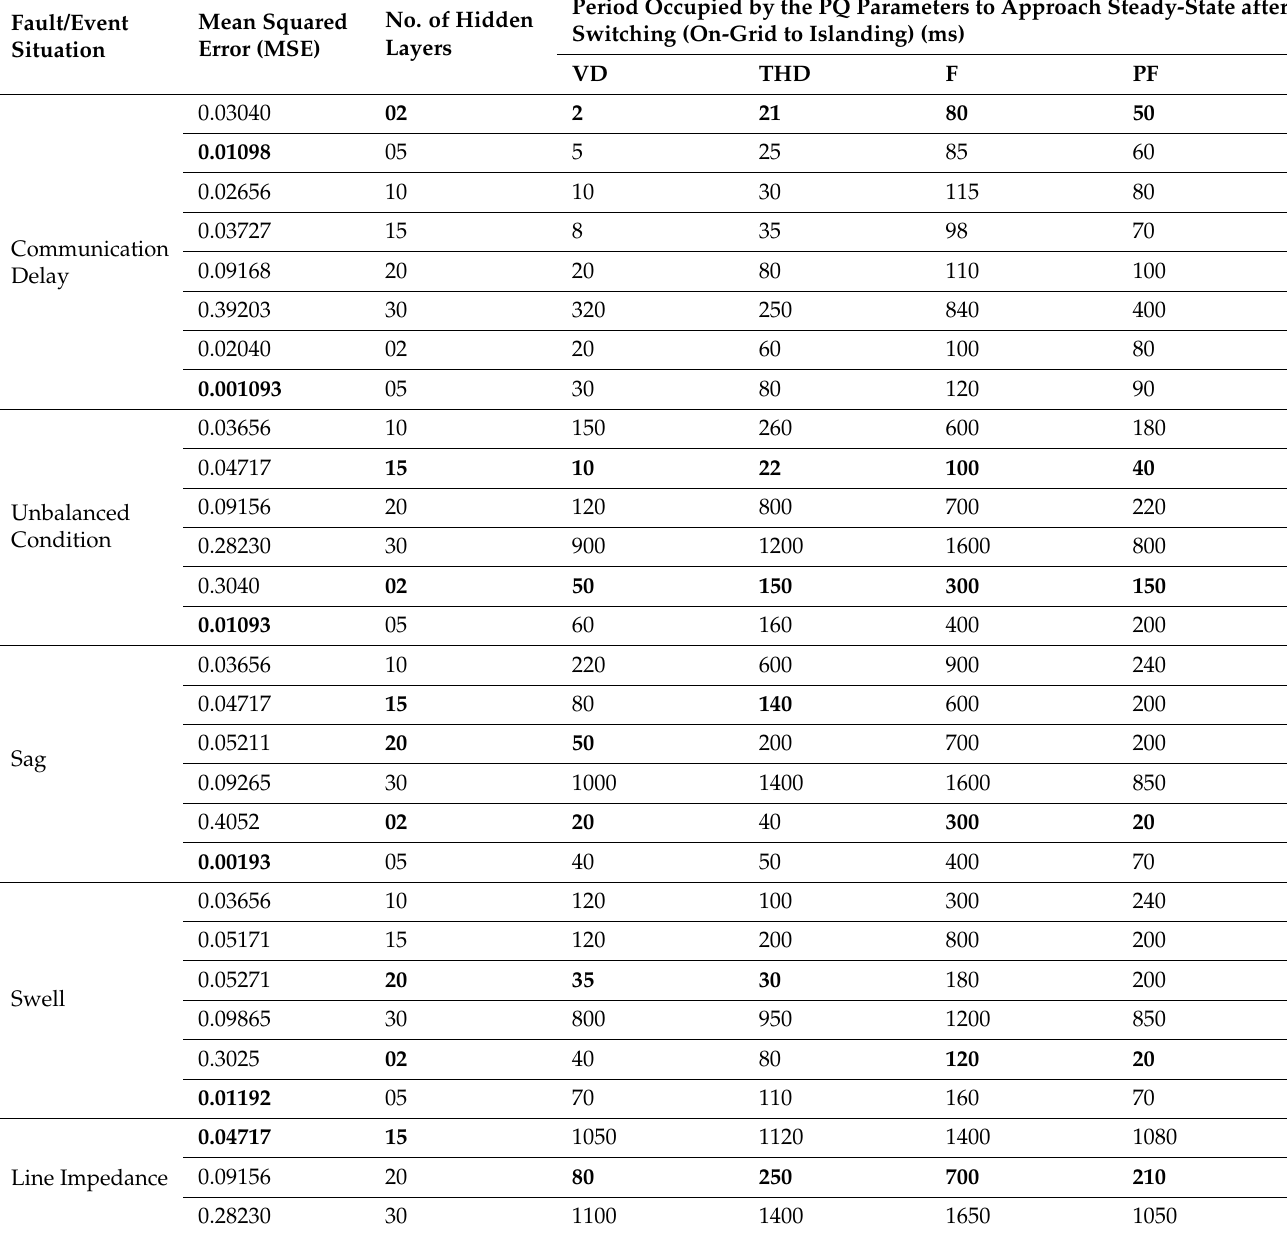
Table 5. Tabulation of PQ Parameters for Different Test